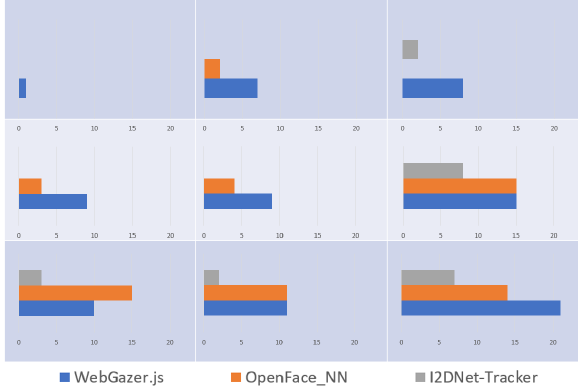
Figure 8. Region-wise miss clicks using three interfaces across the